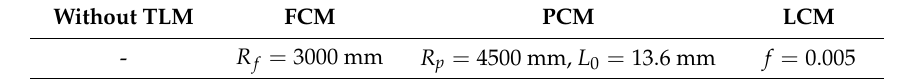
Table 4. Tooth longitudinal modification (TLM) parameters of four cases for the example cycloid gear pair with NNM.